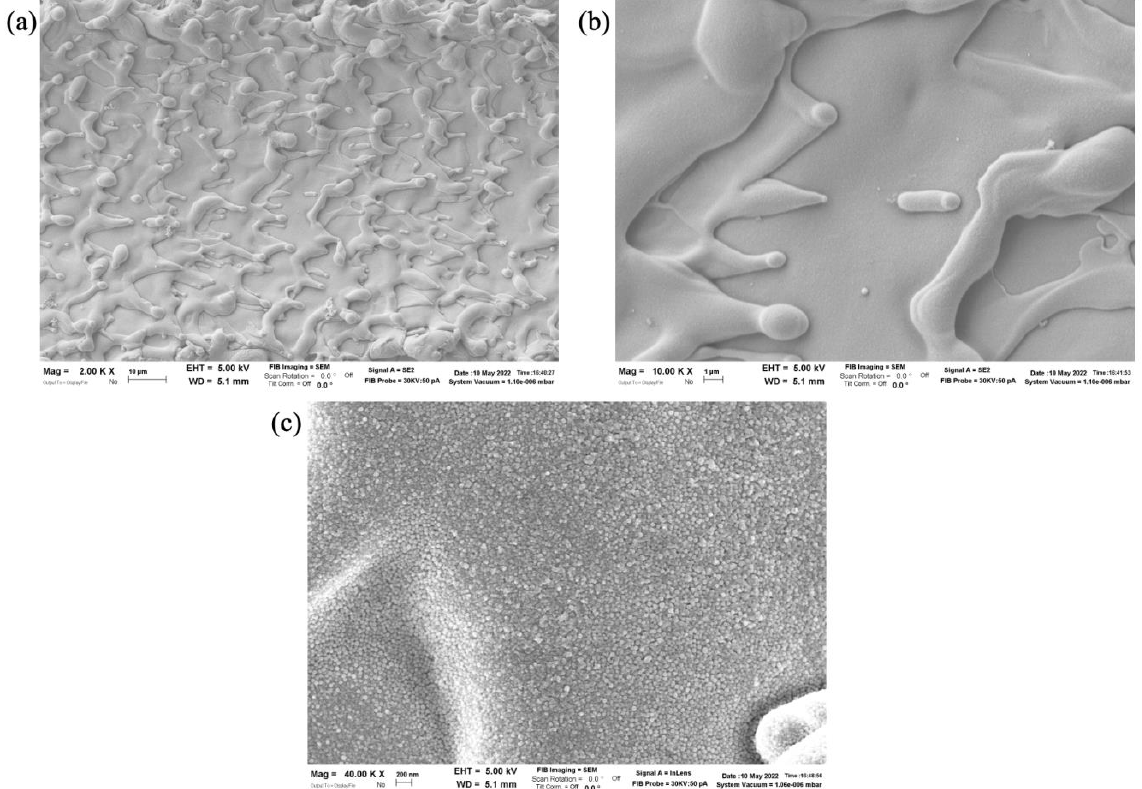
Figure 13. SEM images at ( a ) 2000 × , ( b ) 10,000 × , and ( c ) 40,000 × of surfaces obtained with parallel lines scanning strategy at 12 W: Surf 3 sample (laser texturing + sol–gel (APTES + PE